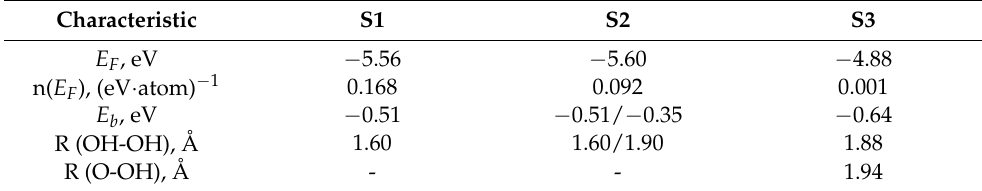
Table 5. Electronic characteristics of HIF-COOH-N-MWCNT structure.